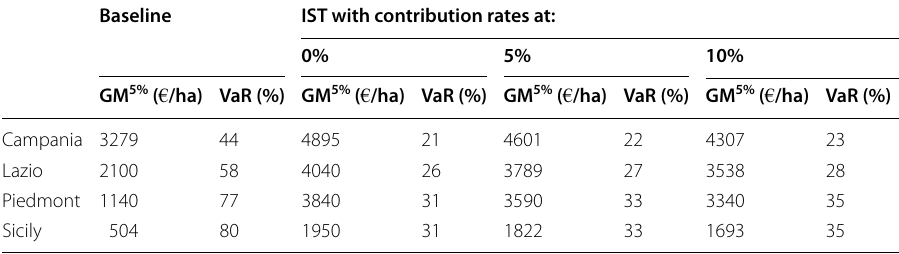
Table 3 Risk indicators by region in the baseline and with the IST Baseline IST with contribution rates at: